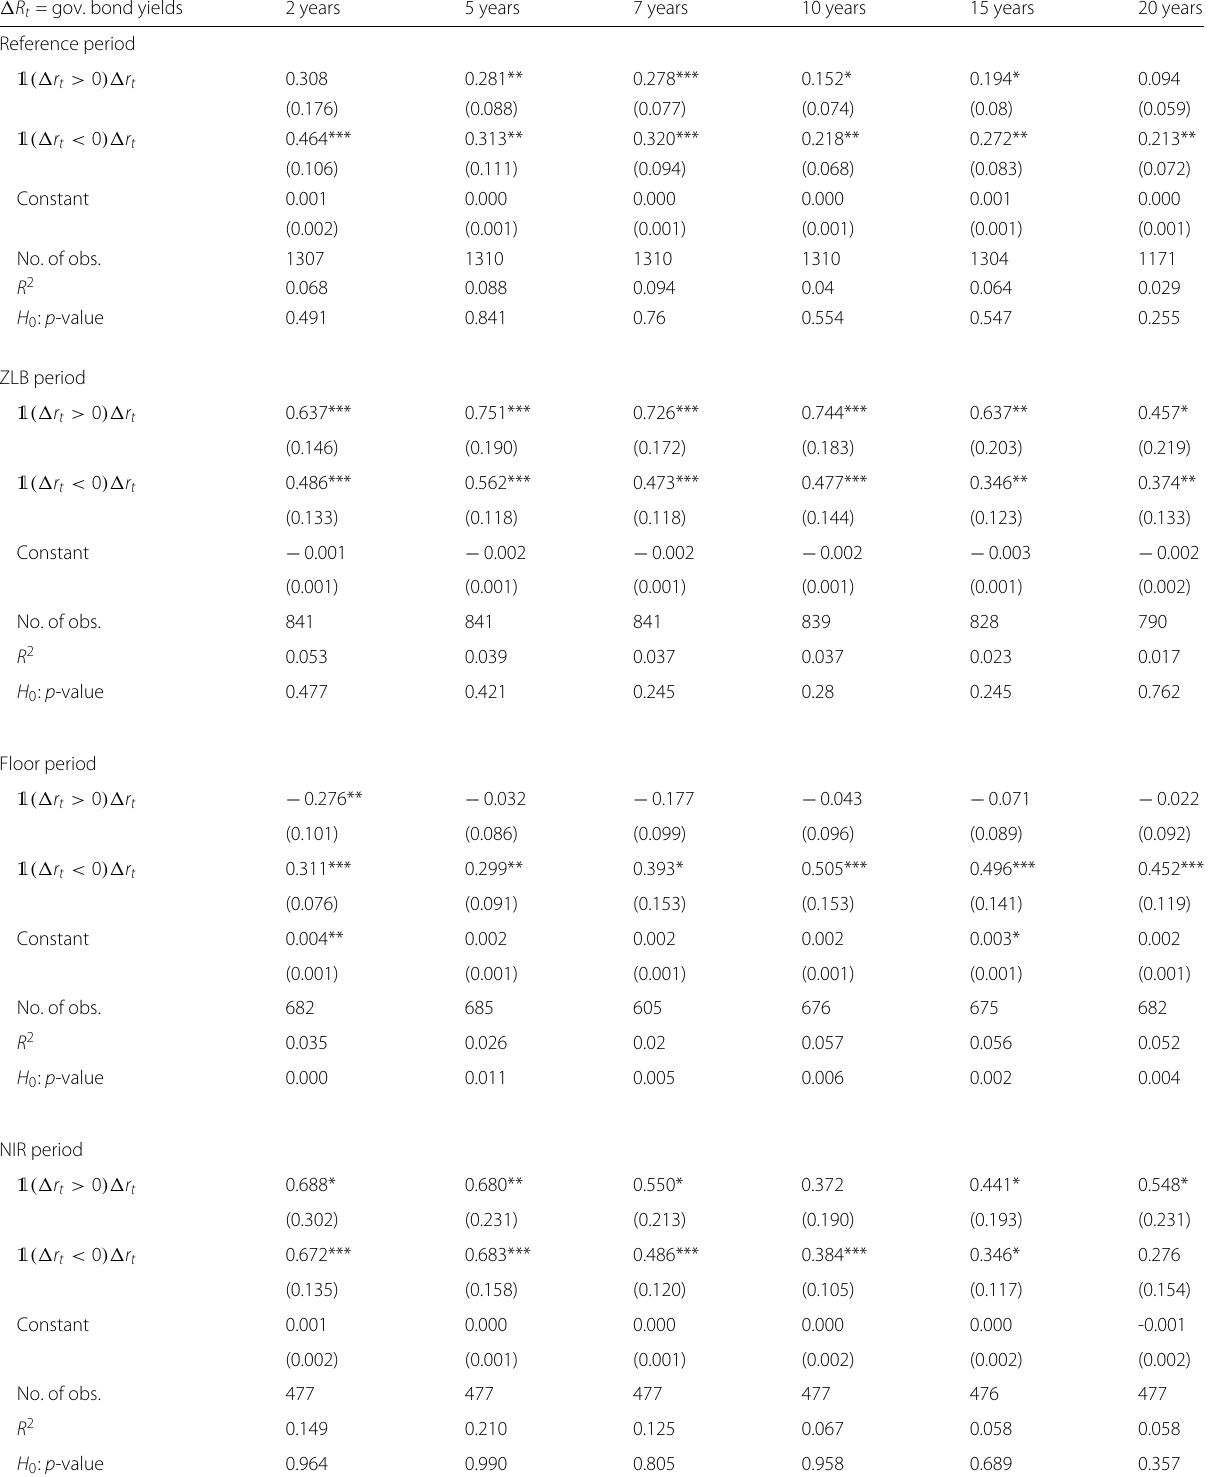
Table 1 Baseline